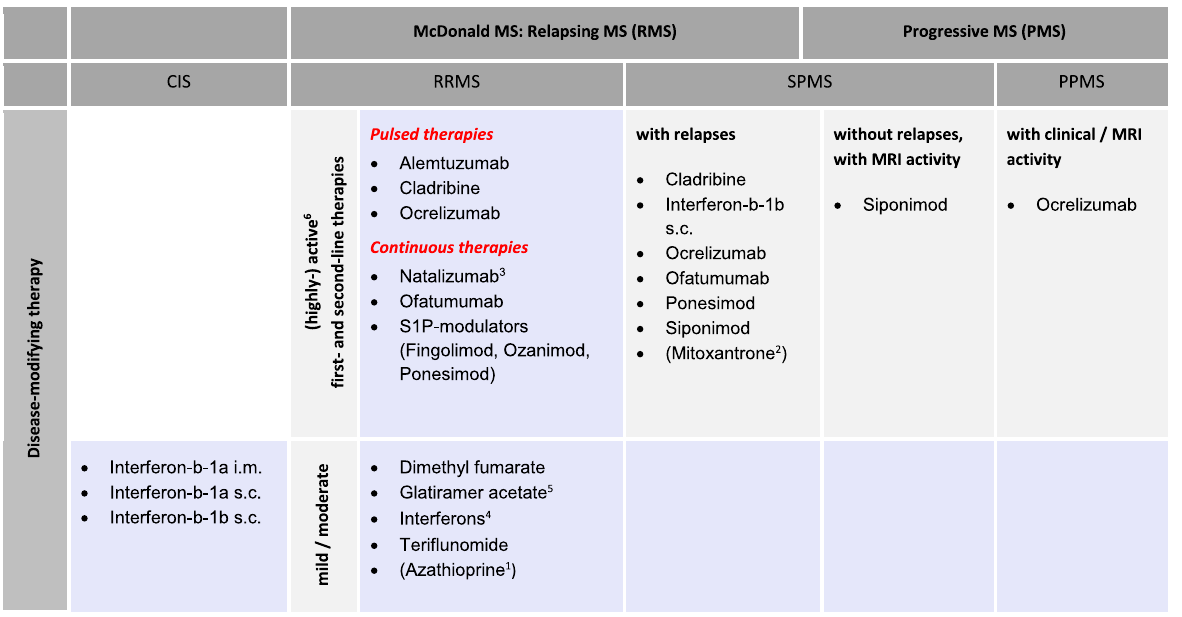
Fig. 1 D ISEASE -M ODIFYING T HERAPY OF MS. 1 - A ZATHIOPRINE IS FORMALLY APPROVED BUT RARELY APPLIED (2 ND CHOICE ); 2 - M ITOXANTRONE FORMALLY APPROVED HERE AS WELL AS IN HIGHLY ACTIVE RRMS BUT RARELY APPLIED DUE TO THE UNFAVORABLE SIDE EFFECT PROFILE AND THE CUMULATIVE MAXIMUM DOSE (2 ND CHOICE ); 3 - N ATALIZUMAB : BOTH I . V . AND S . C .; ESPECIALLY IN CASE OF HP Y V-2 (JCV) ANTIBODY POSITIVITY (HP Y V-2 [JCV] A B ≥ 0.9 HP Y V-2 [JCV] A B TITER ) RISK STRATIFICATION IS ESSENTIAL DUE TO PML RISK ! H IGH RISK FOR PML AFTER I ) PRIOR IMMUNOSUPPRESSION , II ) ≥ 18 MONTHS OF CONTINUOUS THERAPY , AND WITH III ) POSITIVE HP Y V-2 (JCV) A B STATUS ; 4 - I NTERFERONS : INTERFERON - B -1 A I . M ., INTERFERON - B -1 A S . C ., INTERFERON - B -1 B S . C ., PEGYLATED INTERFERON - B -1 A S . C ./ I . M .; 5 - G LATIRAMER ACETATE INCLUDES OTHER GLATIRAMOIDS . 6 - D ECISIONS ON TYPE OF THERAPY ( AS WELL AS THERAPY CONCEPT ) DEPEND ON THE LEVEL OF DISEASE ACTIVITY AND SEVERITY ; THUS FIRST - AND SECOND - LINE THERAPIES ARE INCLUDED HERE .A VAILABLE DRUGS ARE LISTED ALPHABETICALLY , NOT BY STRENGTH OR PREFERENCE .S CHEME FROM : MSTCG, DGN EUROLOGY K OMMENTAR (2021)